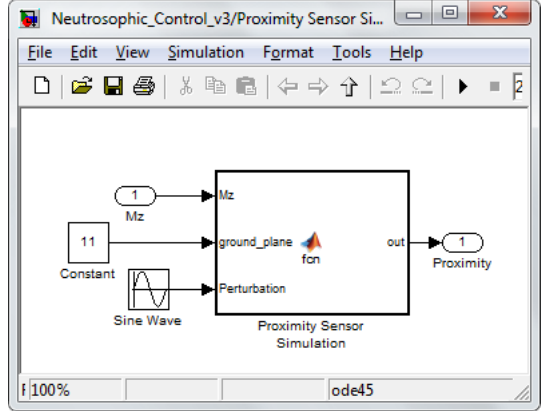
Figure 14. Proximity sensor simulation.